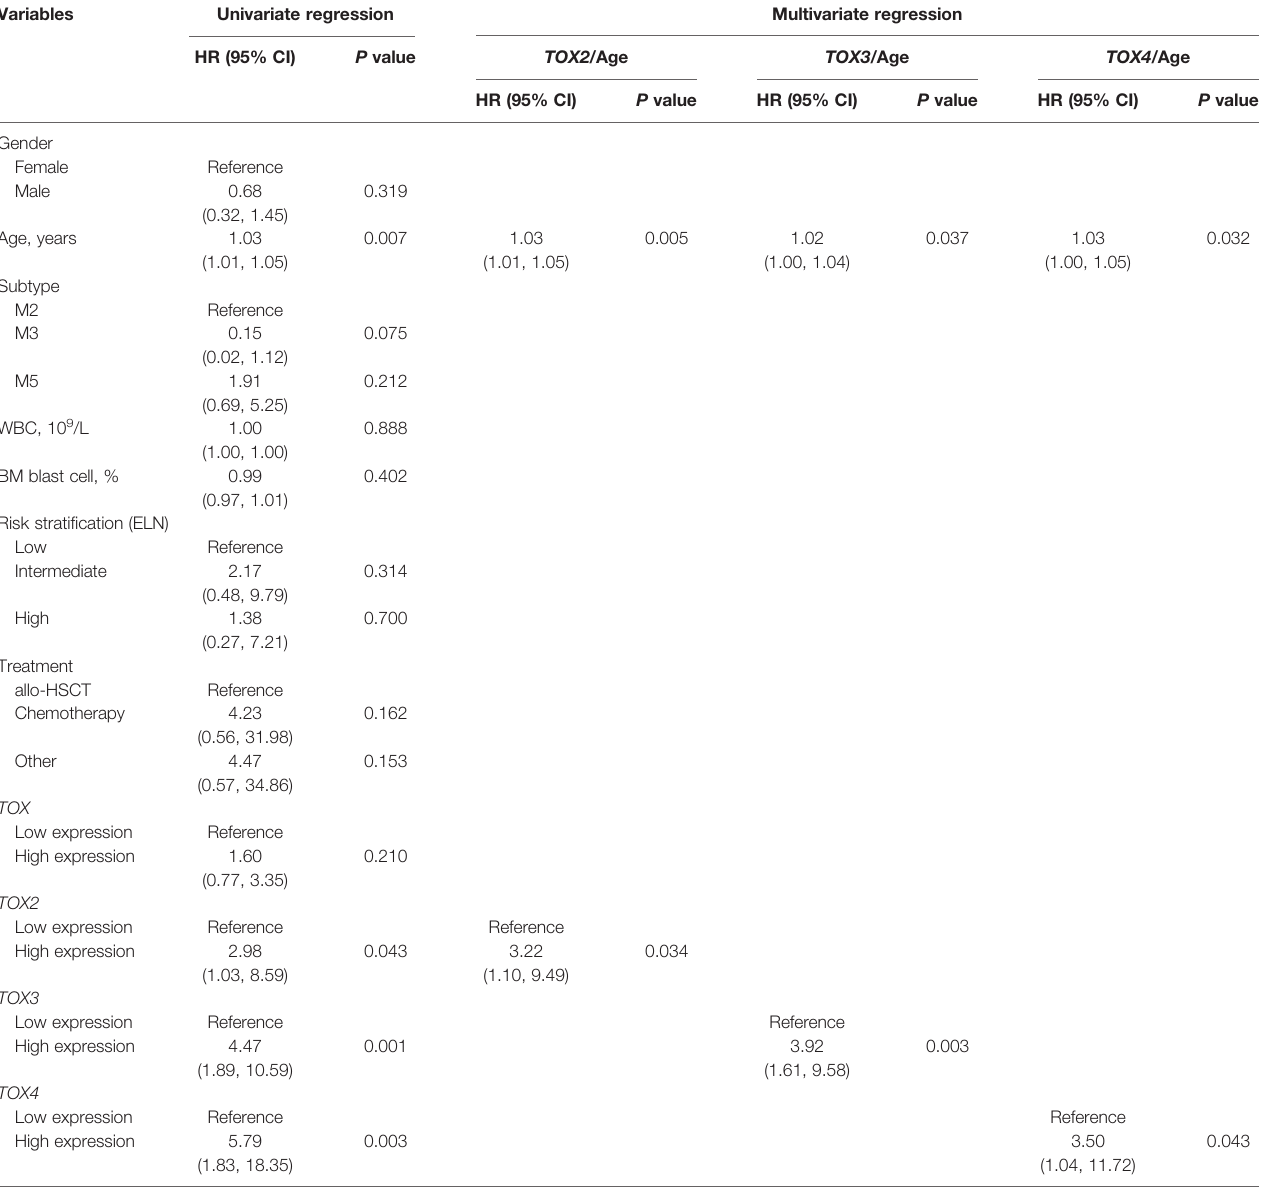
TABLE 2 | Uni- and multivariate regression analysis of TOX2 , TOX3 , and TOX4 in AML patients. Variables Multivariate regressionUnivariate